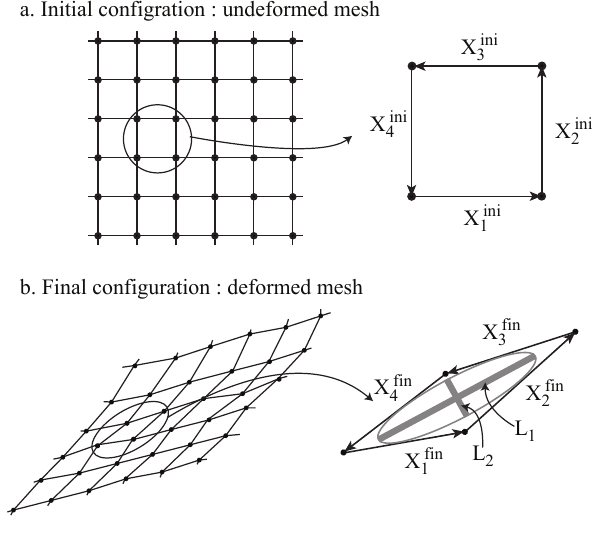
Fig. 2. Schematic representation of the passive marker mesh in the initial configuration (a) and final configuration (b) . The vectors X ini and X fin characterise the mesh and allow for computing the finite i